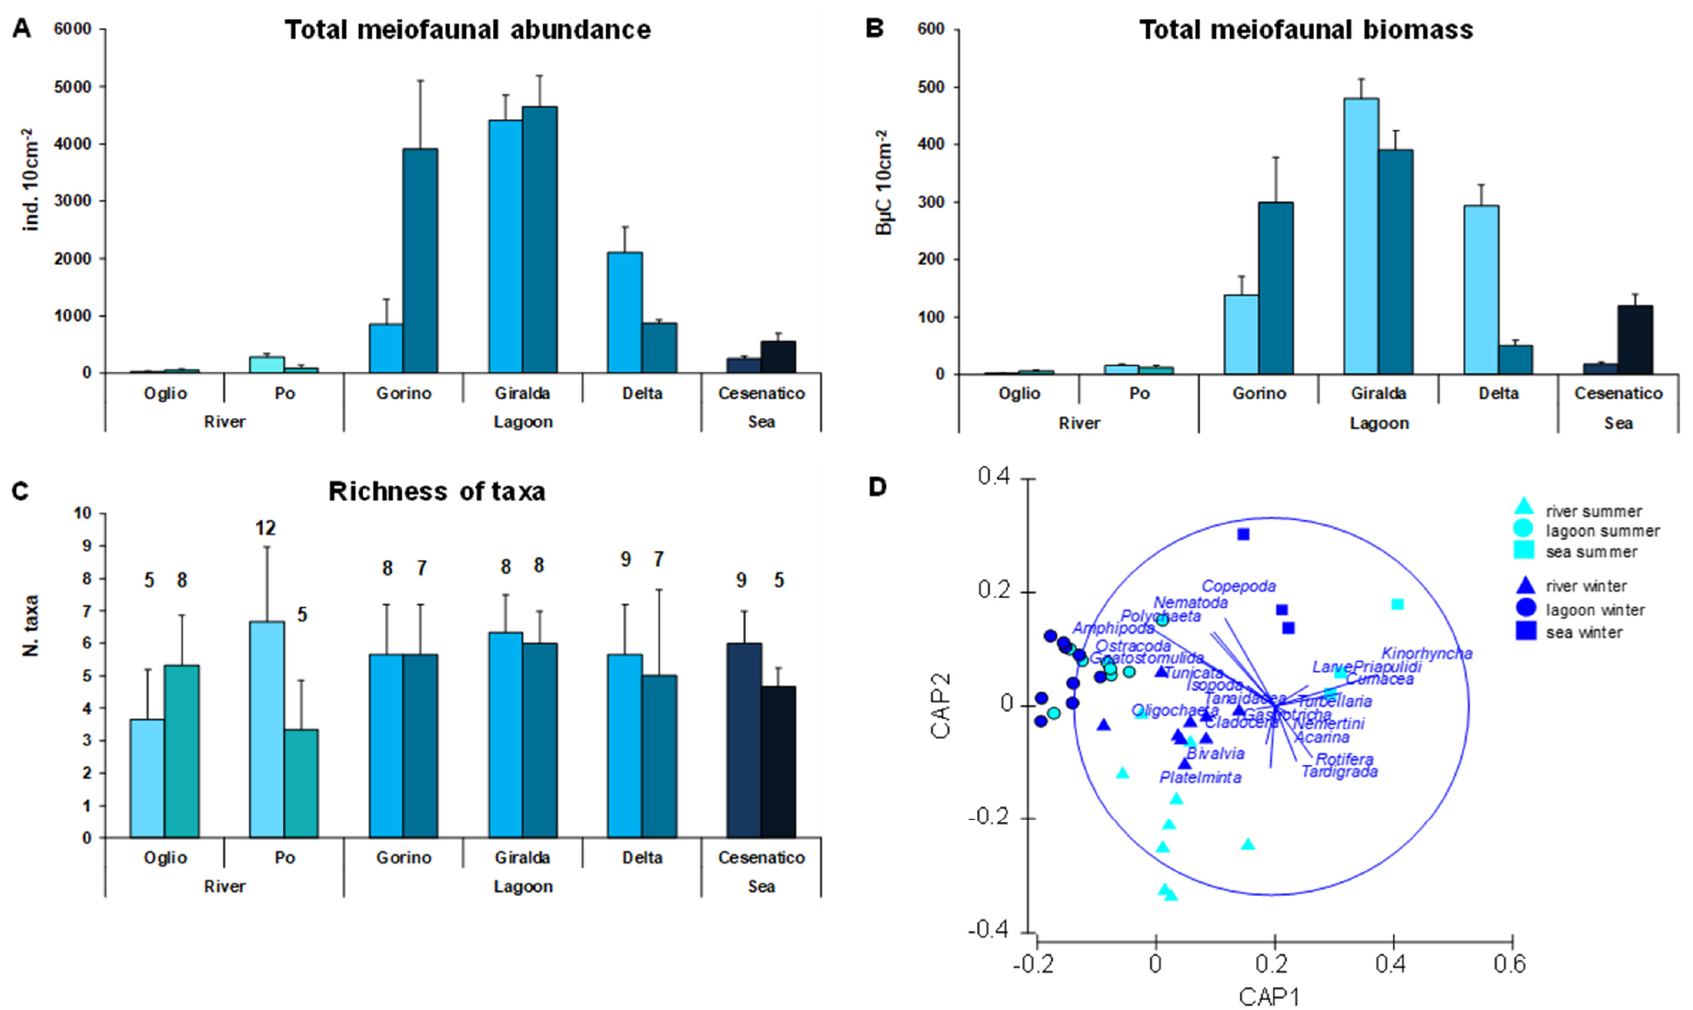
Figure 4. Meiofaunal abundance ( A ), biomass ( B ), richness of higher taxa ( C ), and taxonomic composition ( D ) in the investigated stations in summer and winter.